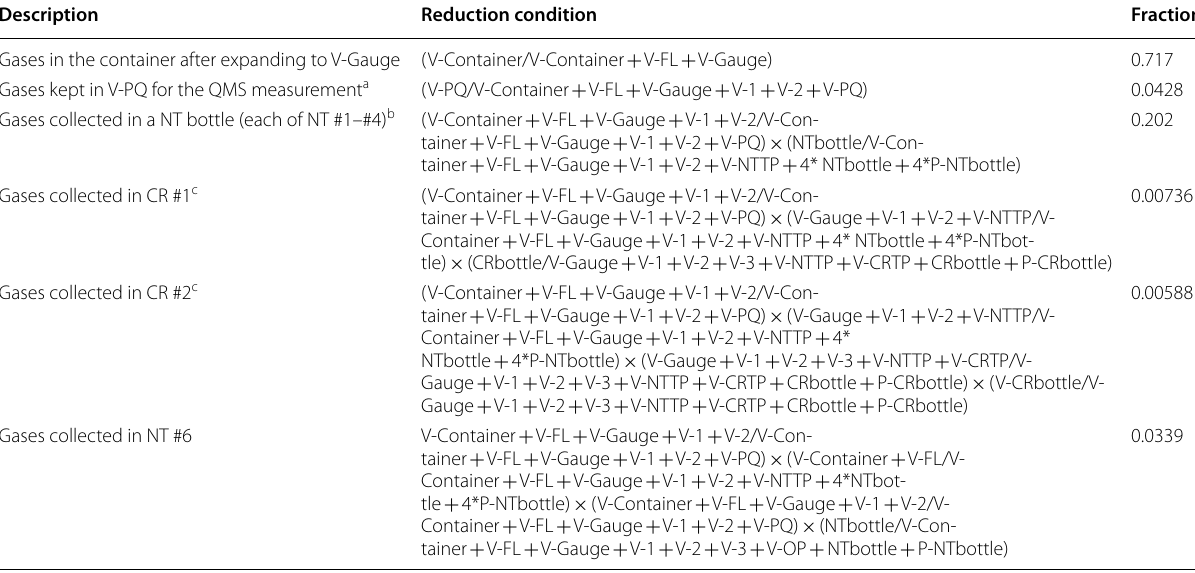
See Fig. 4 and Table 1 for the names and